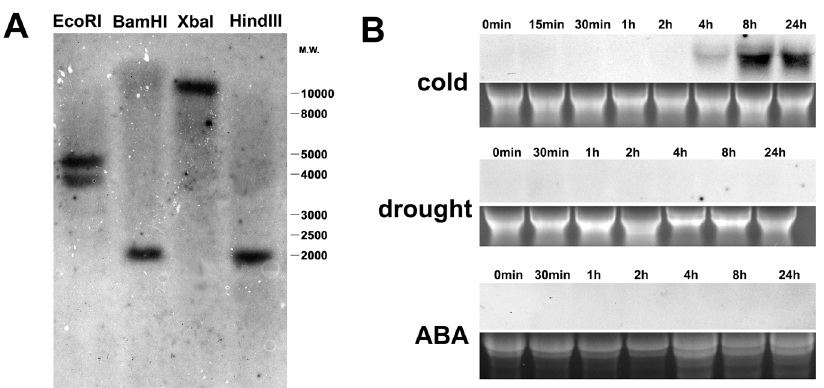
Fig 2. Characterization of HbCBF1 gene. (A) Southern blotting analysis of HbCBF1 gene in Hevea brasiliensis genome. (B) HbCBF1 expression in response to cold, drought stress or ABA treatment. Twenty microgram total RNA from the leaves of the seedlings treated with cold, drought or ABA for the indicated time were used for Northern blotting analysis. HbCBF1 full length cDNA was used as probe. EtBr-stained rRNA was used as an internal standard to monitor equal loading of total